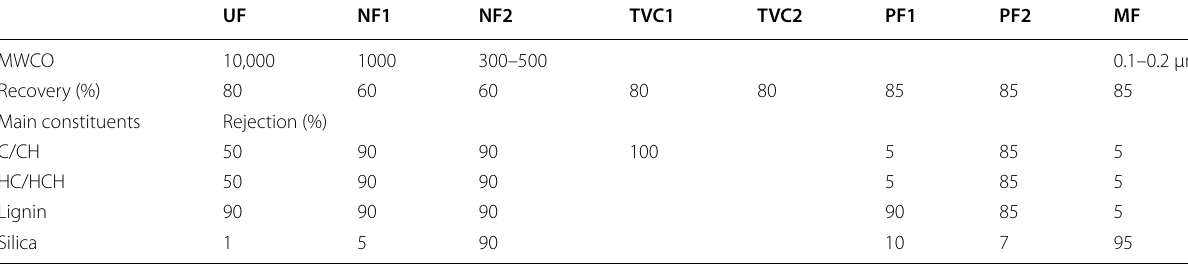
Table 1 Performance indicators for the selected units in the developed